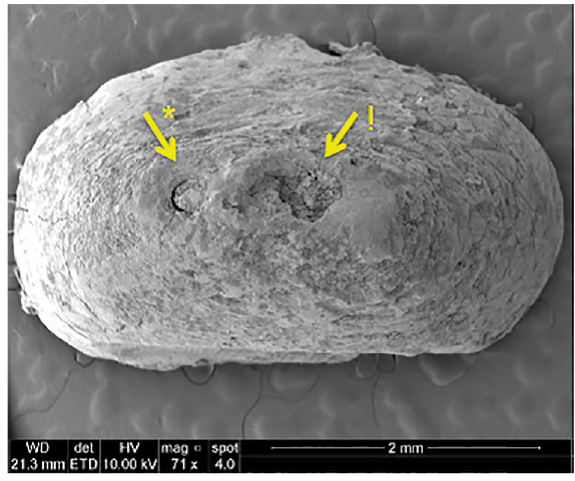
Figure 1. SEM demonstrating the general appearance of the root apex - visualization of the main foramen (* → ) and foramina (! → ).